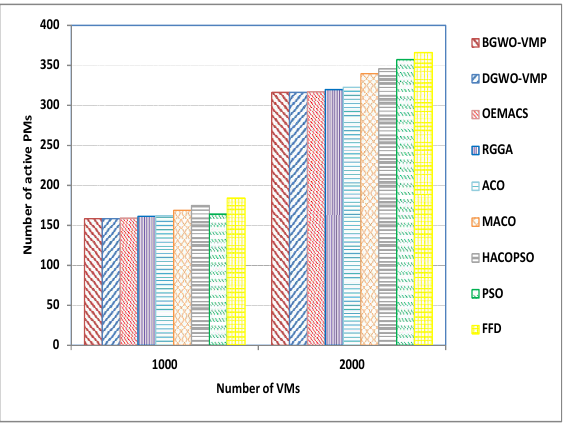
Figure 3. Numbers of active physical machines (PMs) for homogeneous instances of large-sized problems A7 and A8.